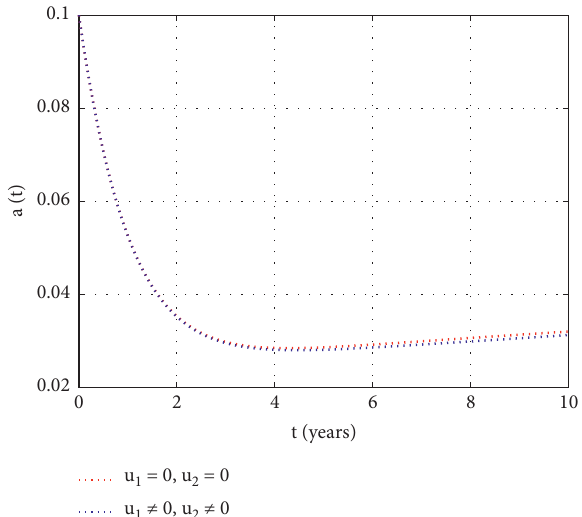
Figure 7: Simulation of AIDS population size without and with controls.